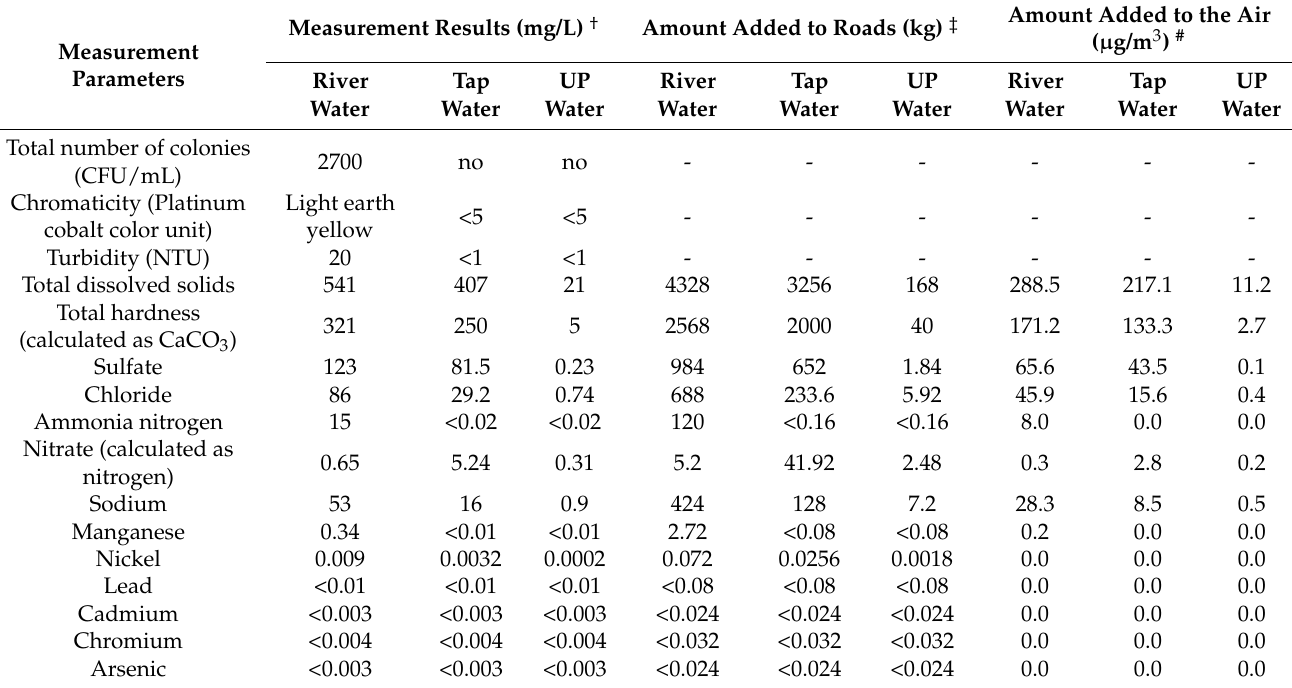
Table 1. The measured amounts for chemical components in the three types of water and their estimated values on the road surface and in the